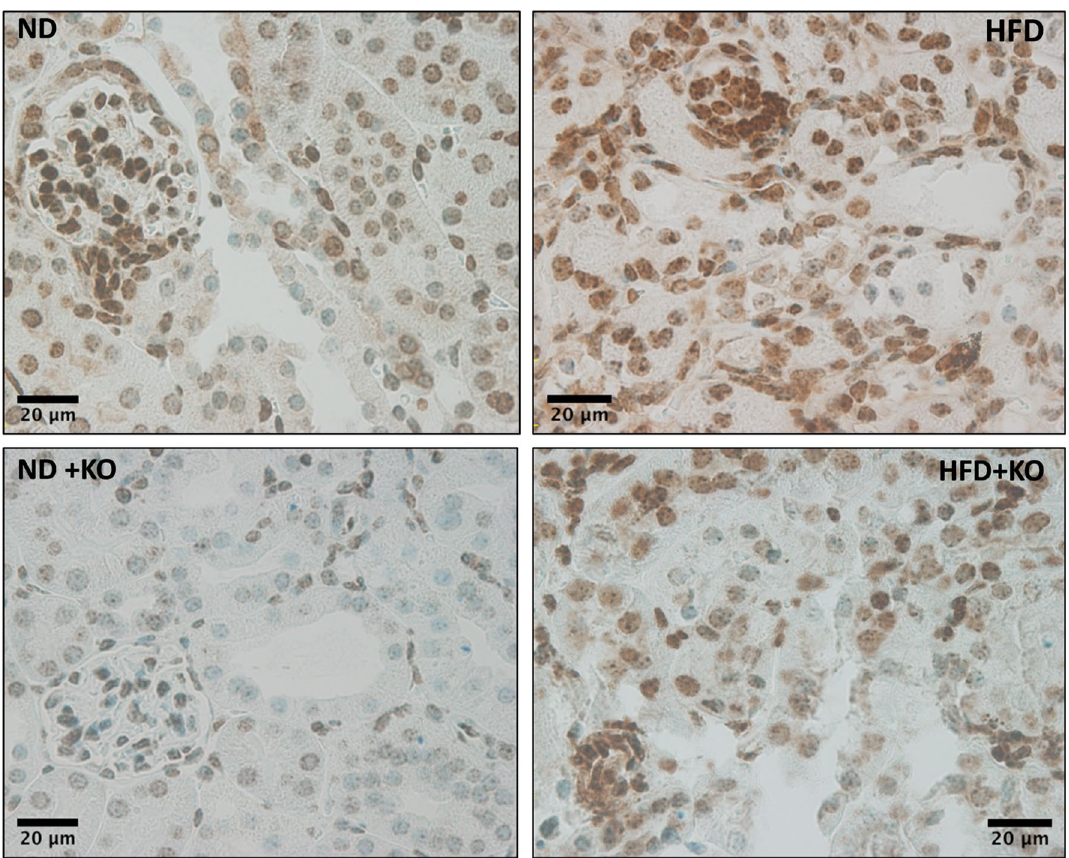
Figure 3. Immunostaining of renal Atp6ap2. Immunostaining of renal cortical Atp6ap2 after 8 weeks following normal diet (ND) and high fat diet (HFD) in mice with or without